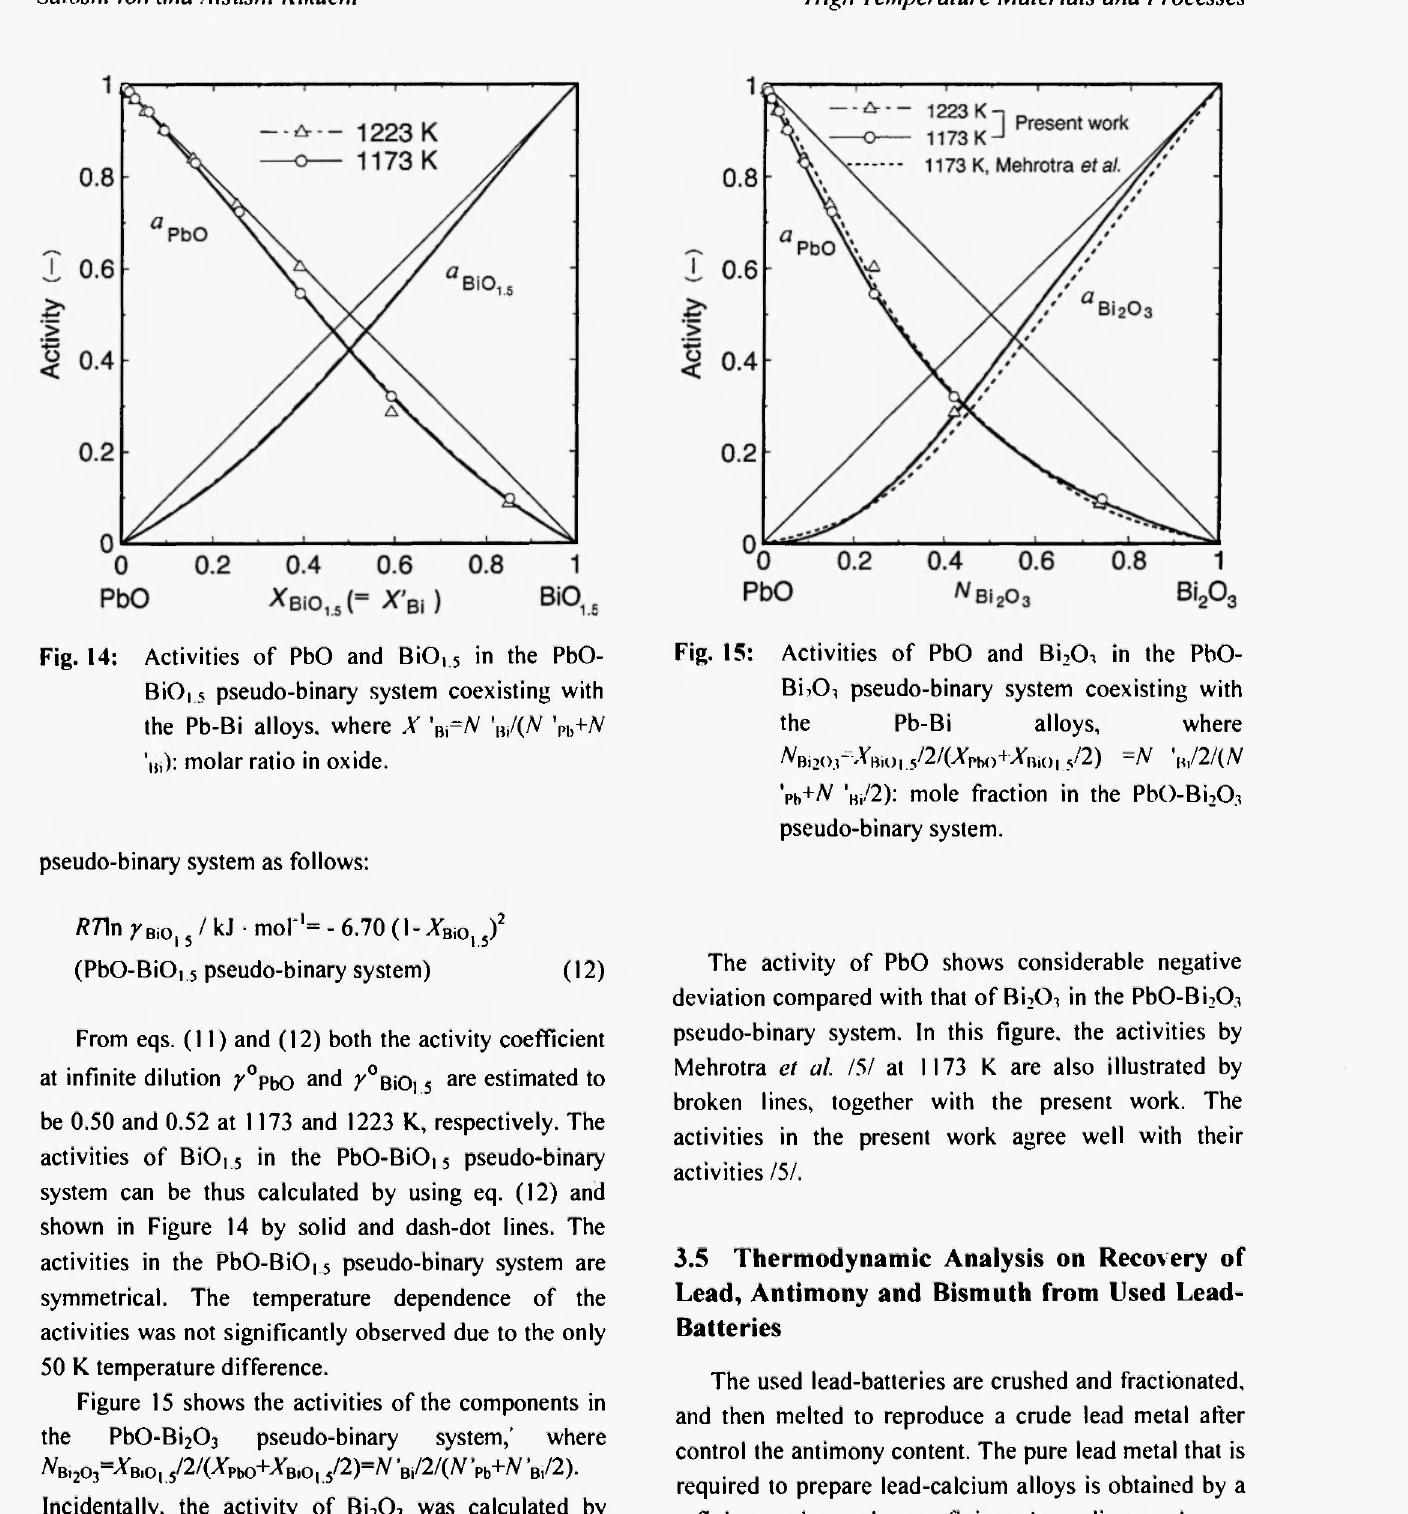
Fig. 15: Activities of PbO and Bi 2 0, in the PbO- Bi,Oi pseudo-binary system coexisting with the Pb-Bi alloys, where NBi 2 o.r-* B , 0| mX m ,+X mH 5 /2) =N 'h,/2/(,V Vb+/V Vi/2): mole fraction in the Pb0-Bi 2 0 3 pseudo-binary